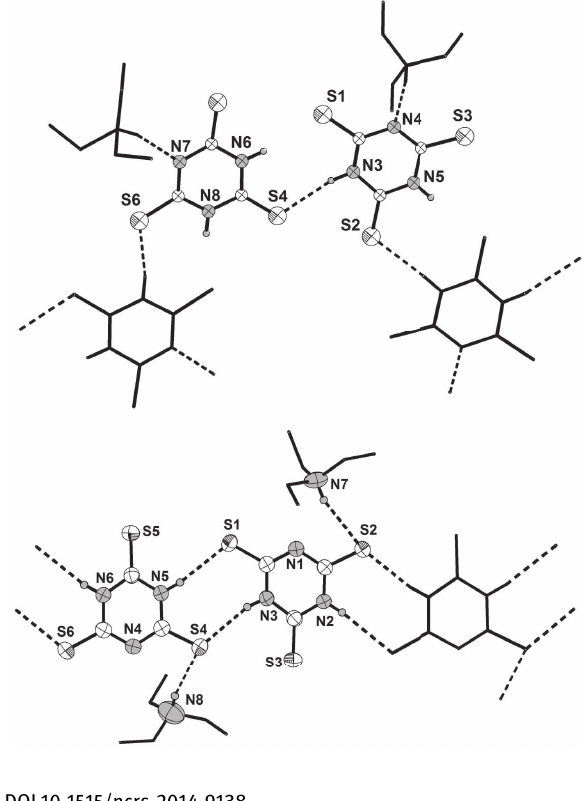
Table 1: Data collection and handling.